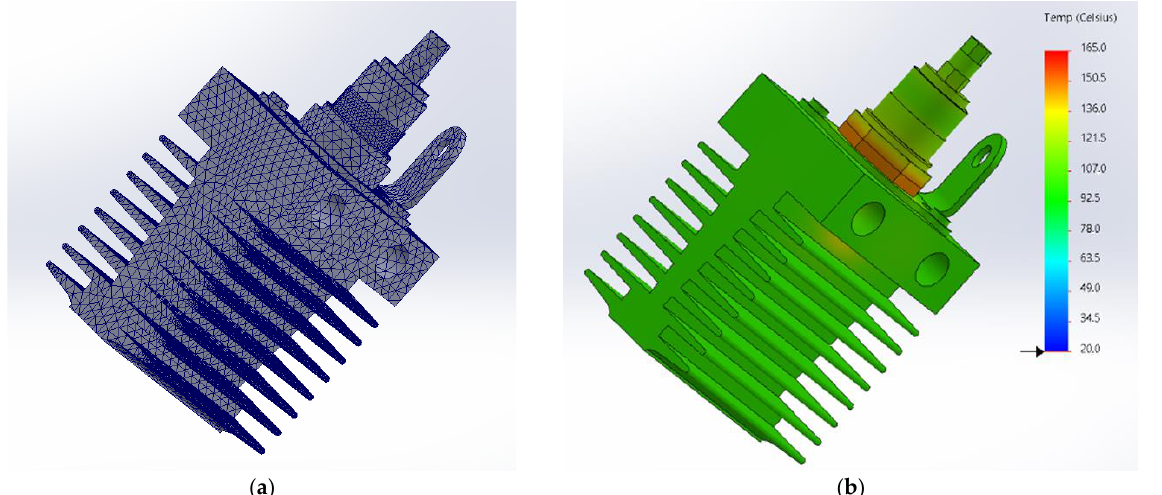
Figure 9. ( a ) The view of the diode model for the smallest mesh element value of 1.0 mm. ( b ) The simulation result for the smallest mesh element value of 1.0 mm ( t s = 280 s; T j = 162.8 °C; P j = 117.99 W; the temperature ranges from 20 °C to 165 °C).